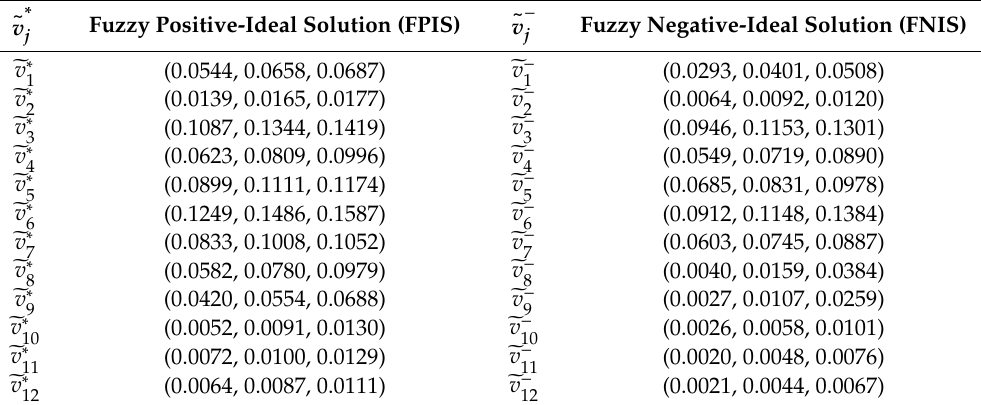
Table 12. Fuzzy positive-ideal solution (FPIS) and fuzzy negative-ideal solution (FNIS).